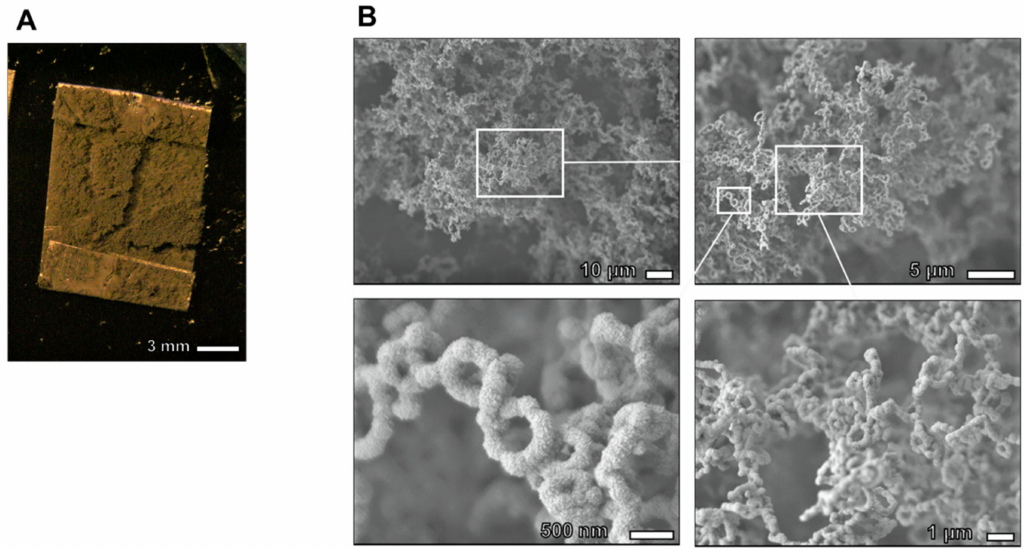
Figure 3. Fabrication of 3D nanostructure using critical point drying method. ( A ) Optical microscope image and FE-SEM images of nanoring-chained 3D structure obtained by adding HCl aqueous. The precipitates deposited on Pd plate at a thickness of 100 µ m or more. ( B ) SEM images of Pd